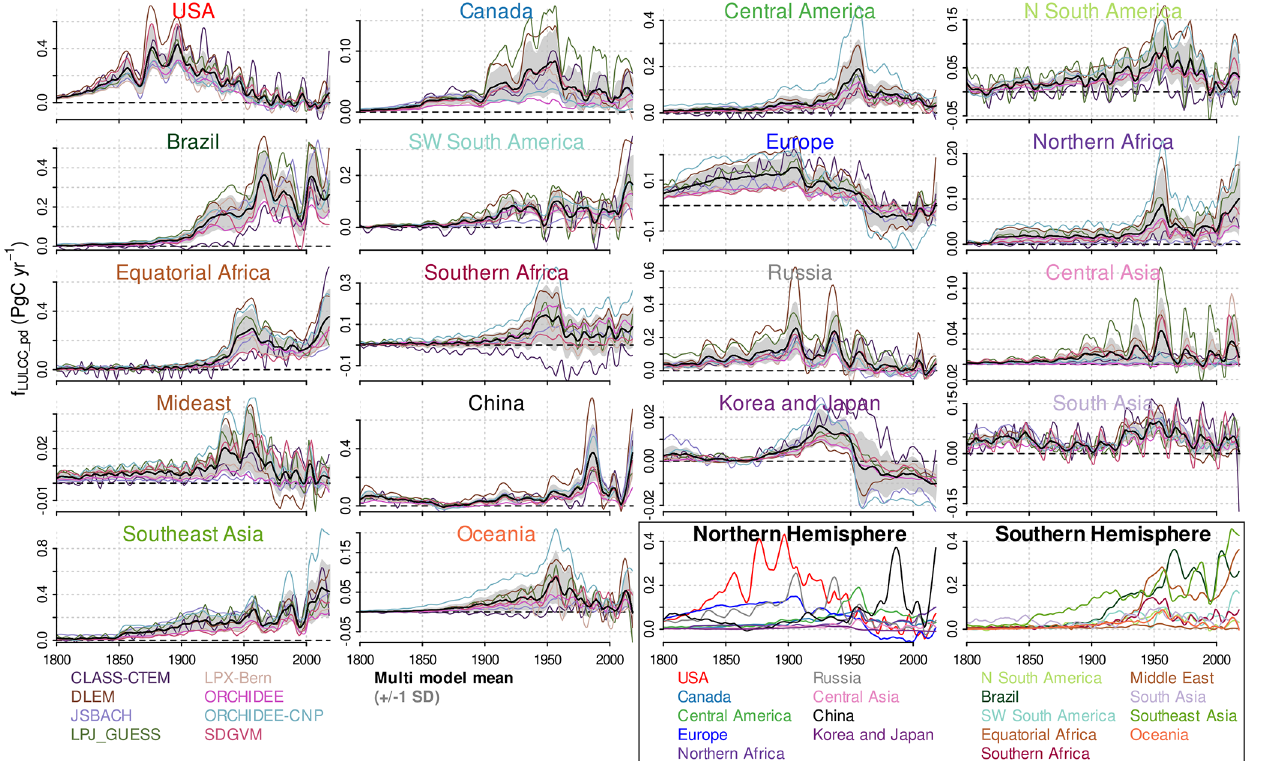
Figure A9. Region-wise smoothed annual f LULCC_pd for different models from 1800 onward (compare Eq. 3). f LULCC_pd was not derived for CLM5.0, JULES, LPJ, and OCN models (compare Table 2). For a discussion of individual models refer to Sect. A1. The last two panels show regional ensemble means on a uniform